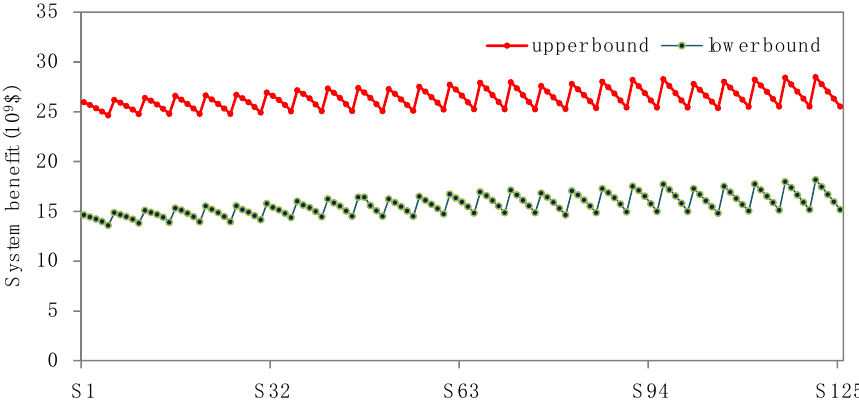
Figure 3. System’s benefits in different scenarios.